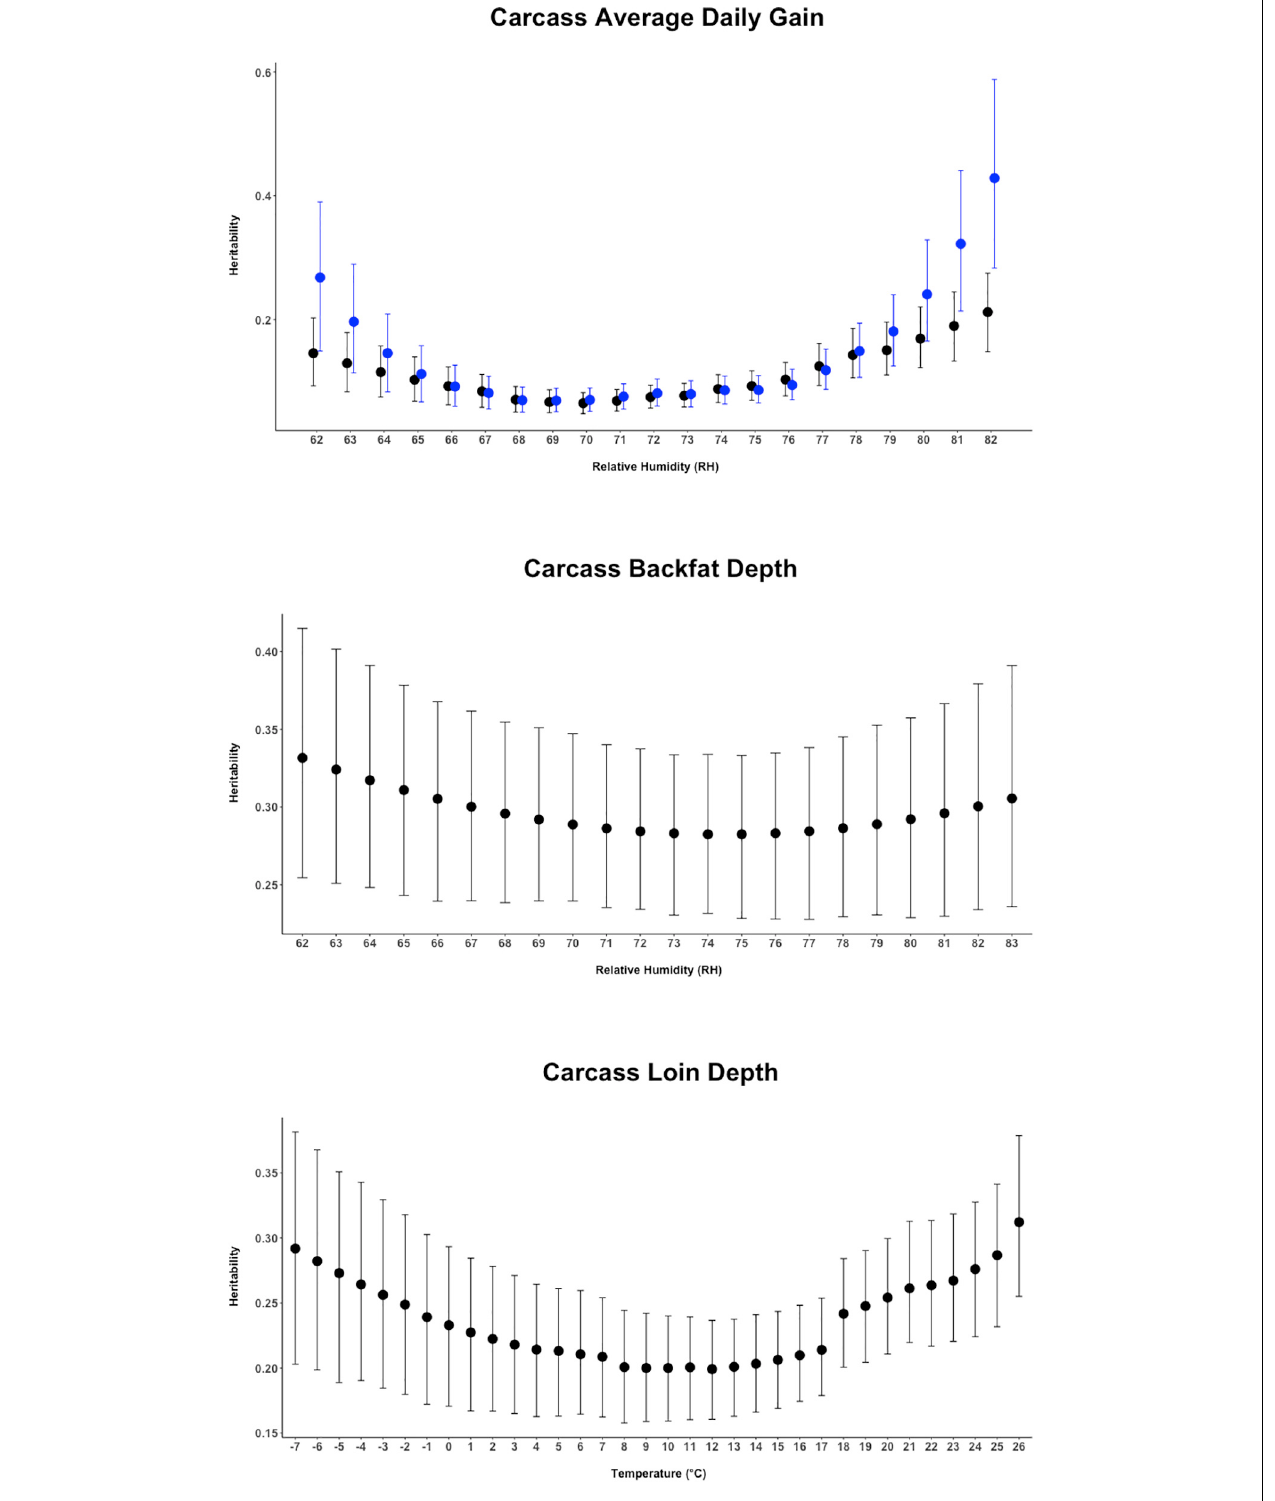
FIGURE 2 | Heritability estimates (95% empirical confidence intervals) for the three carcass quality traits of animals over the range of the respective climatic variable. The black dots report the estimates from the first-order Legendre polynomial random regression model. The blue dots report the estimates from the second-order Legendre polynomial random regression model (available for Carcass Average Daily Gain